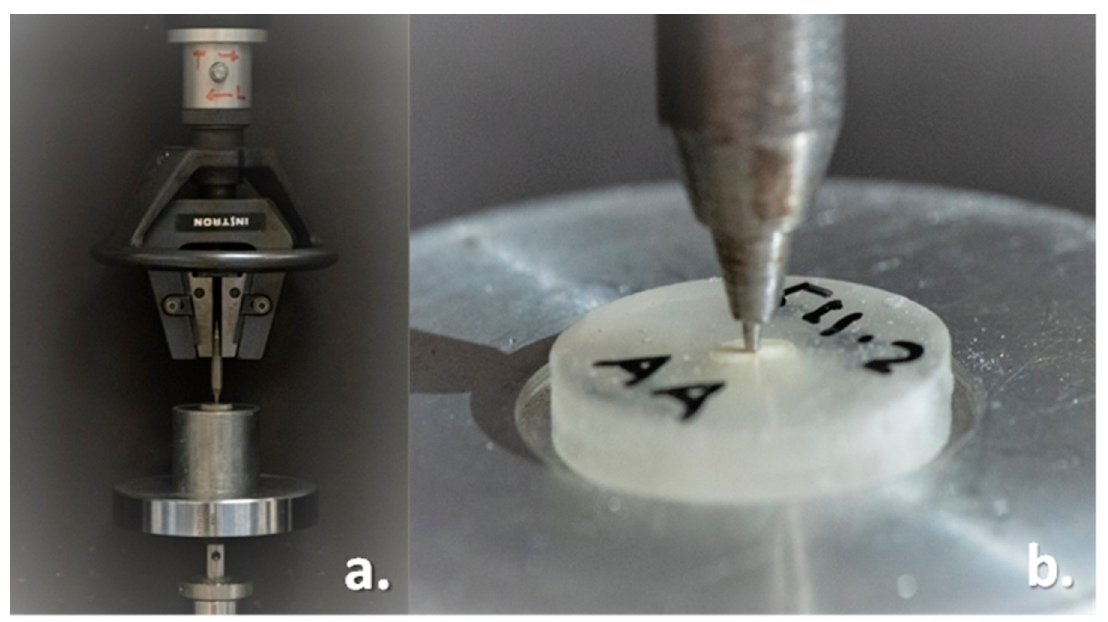
Figure 5. ( a ): Specimen attached to the universal testing machine for push-out test; ( b ): Close up view of the slice attached to push-out jig with plunger centered on the post.